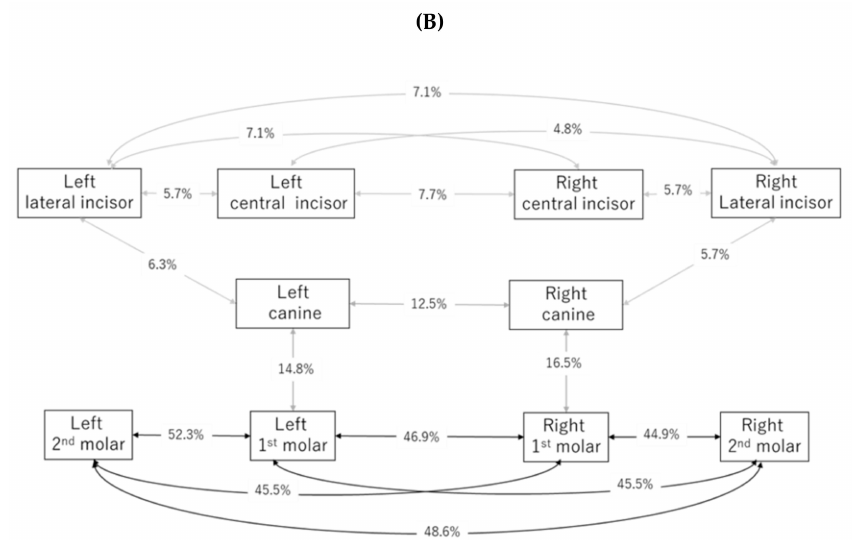
Figure 2. Network plot of co-incidence of dental caries. ( A ) Maxillary arch; ( B ) mandibular arch.